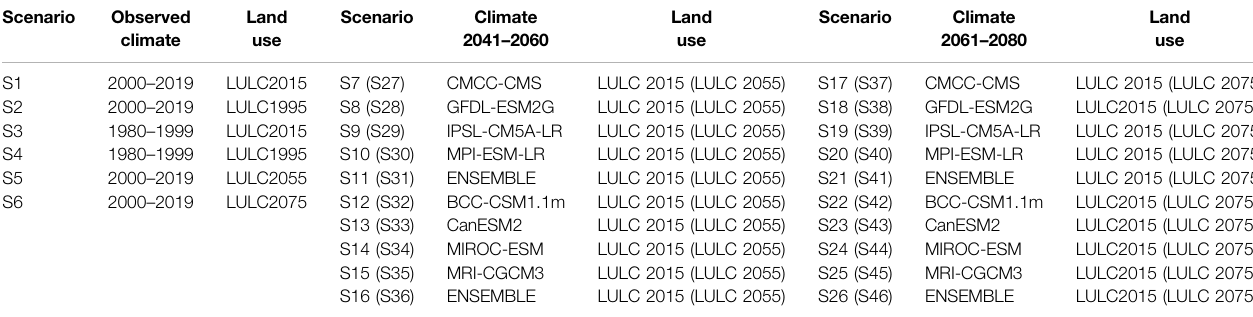
TABLE 4 | The simulated scenarios in the SWAT